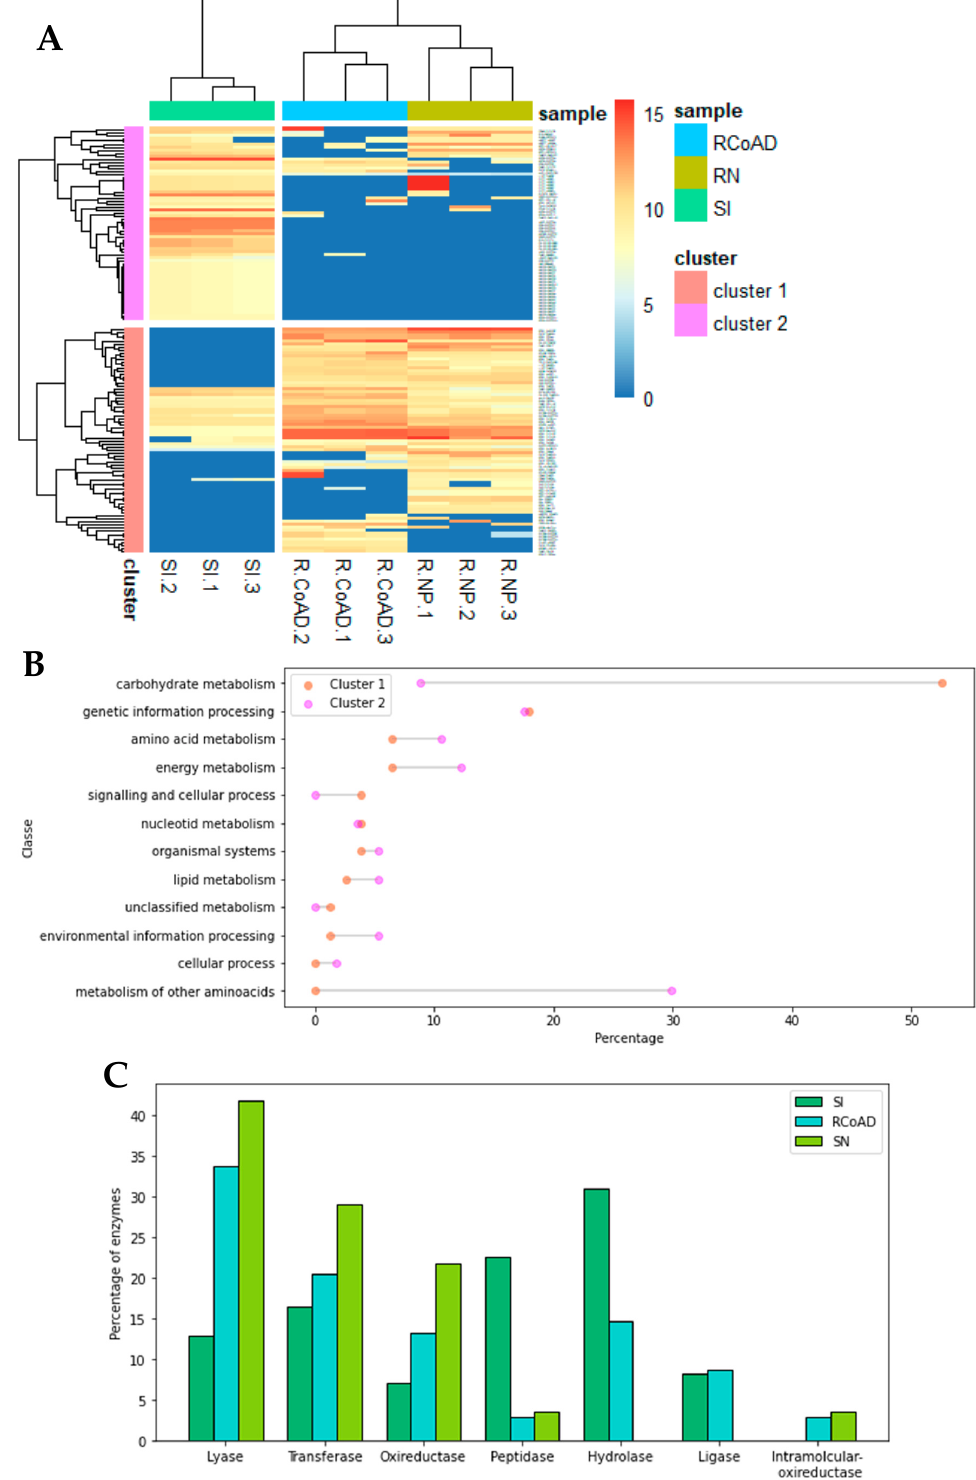
Figure 4. ( A ) Hierarchical clustering analysis of the abundance profiles of the identified 139 proteins. The nine columns represent triplicates of different treatments (SI, R-CoAD and R-NP). The rows represent individual proteins. The more and less abundant proteins are, respectively, shown in orange and blue. The intensity of color increases with increased abundance differences, as shown in the bar. ( B ) Functional categories of clusters originated in ( A ). The two different clusters were ana- lyzed using BlastKOALA and are comparatively shown as a bar chart. ( C ) Molecular functions of samples, according to UniProtKB ontology (GO) gene classification.